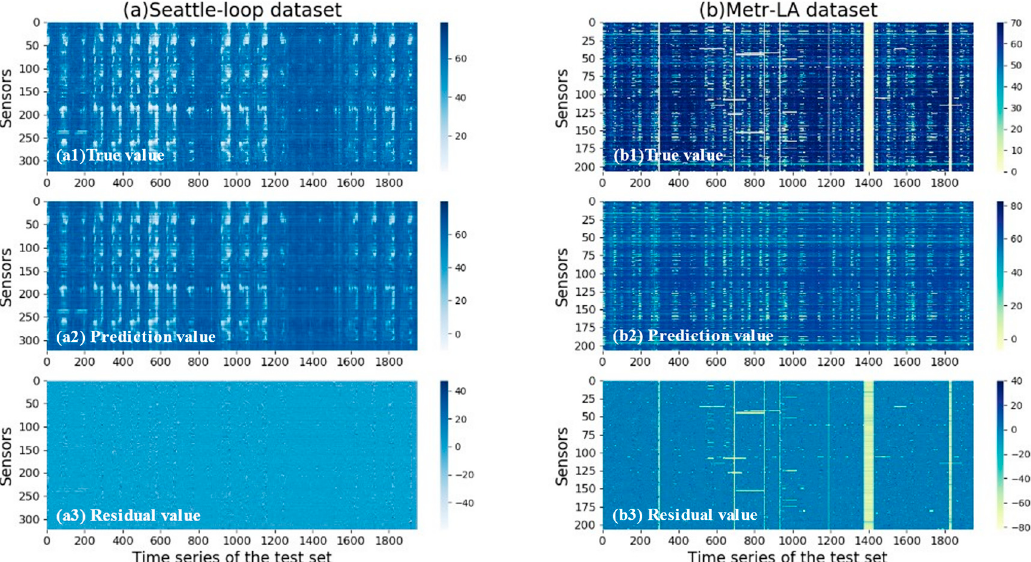
Figure 11. Visualization results of the predicted maps by the ST-CRMF model for 15-min forecasting interval.